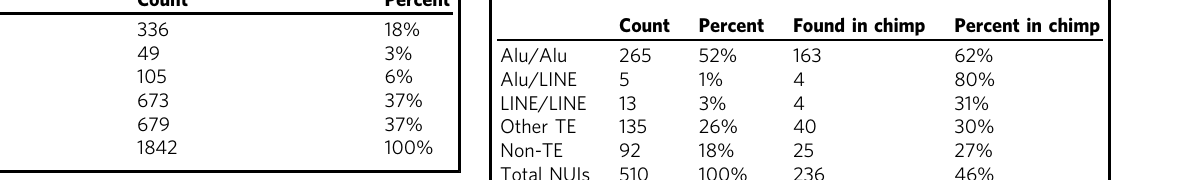
Table 4 Distribution of transposable elements fl anking non- reference unique insertions with at least 10 bp